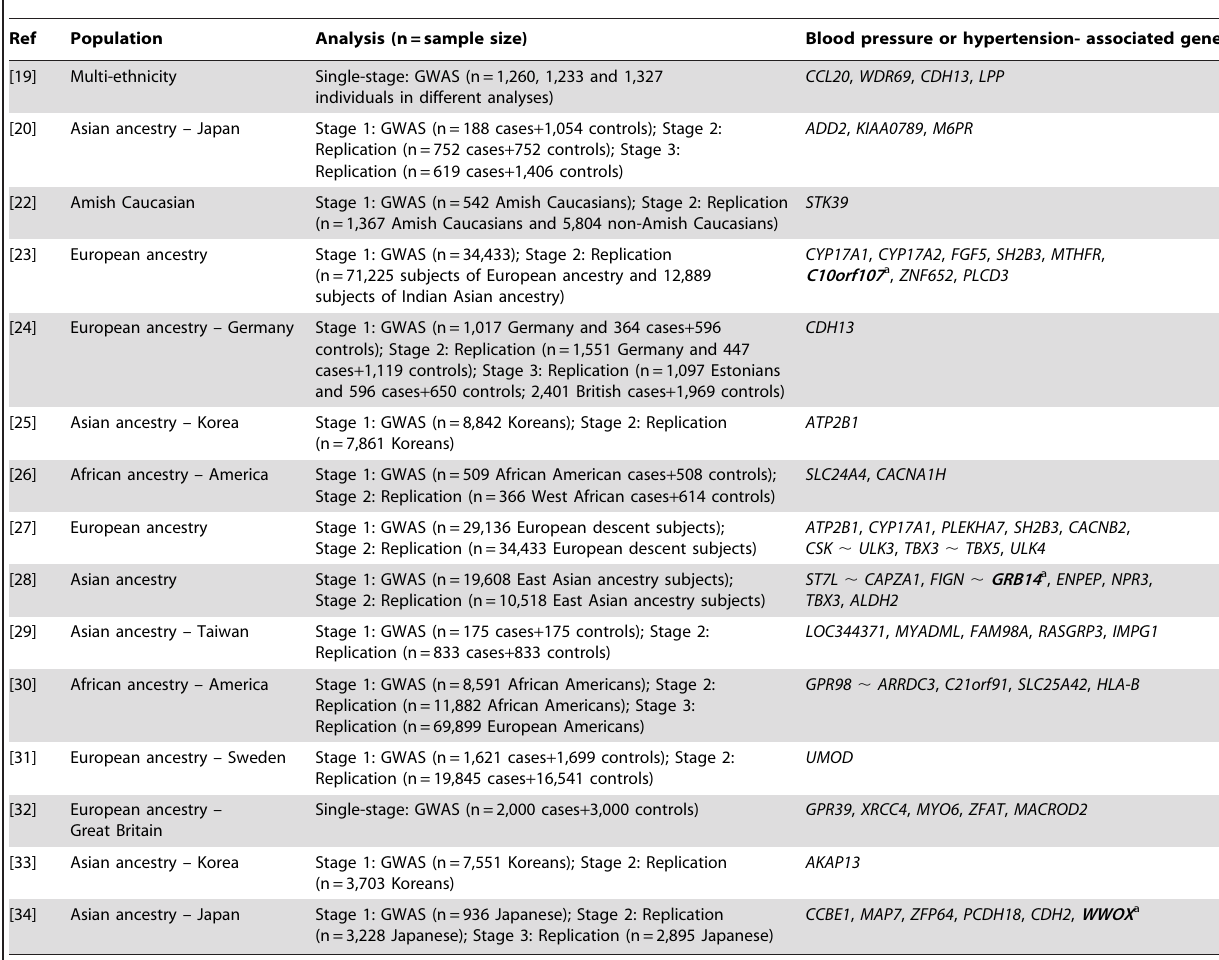
Table 1. A summary table of blood pressure and hypertension susceptibility genes identified by using